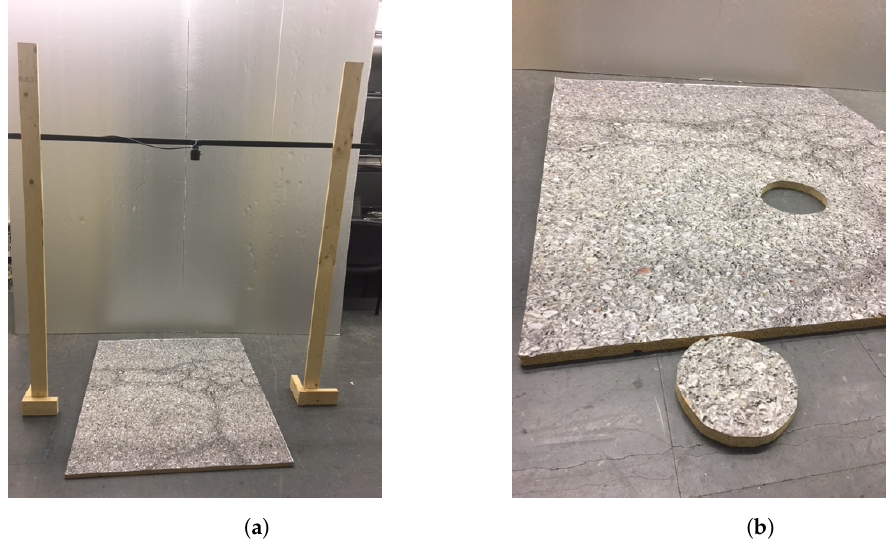
Figure 13. Experimental setup for accuracy analysis of the proposed 3D reconstruction technique. The camera to road distance h is set to be h = 900,1000,1100,1200,1300,1400,1500,1600 mm. A flat plate with mimic road surface pattern is placed as a planar road. A hole on the plate can be used to simulate the road defect. ( a ) A height-adjustable gantry for the camera. ( b ) A flat plate sticked with a mimic road pattern image.